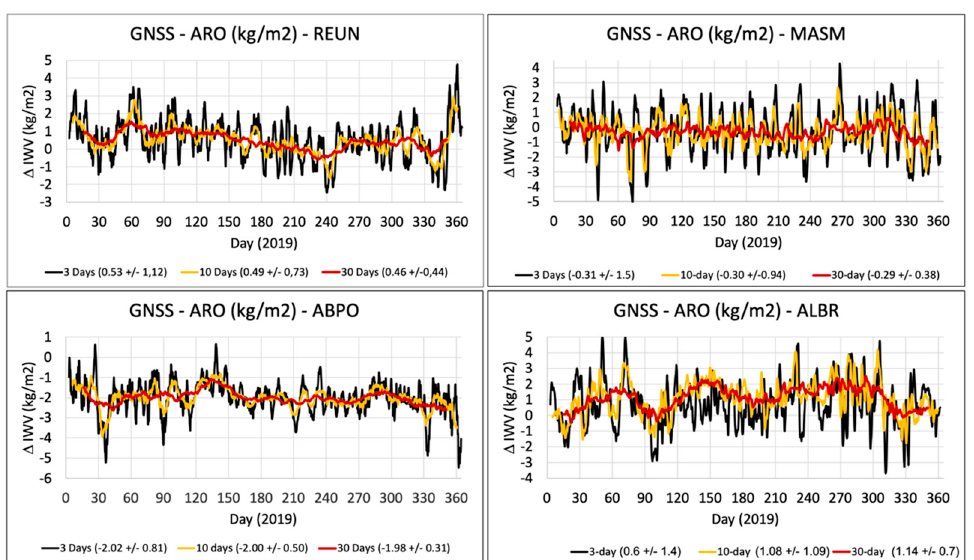
Figure 22. Time series of the differences between IWV contents observed by GNSS and AROME-IO analyses at Réunion Island (REUN, upper left), Sainte-Marie (MASM, upper right), Antananarivo (ABPO, lower left) and Aldabra (ALBR, lower right) throughout the year 2019. 30-day (red), 10-day (orange), and 3-day (black) moving averages were applied to IWV data to evaluate the impact of short and mid-term moisture variations on the model performance.